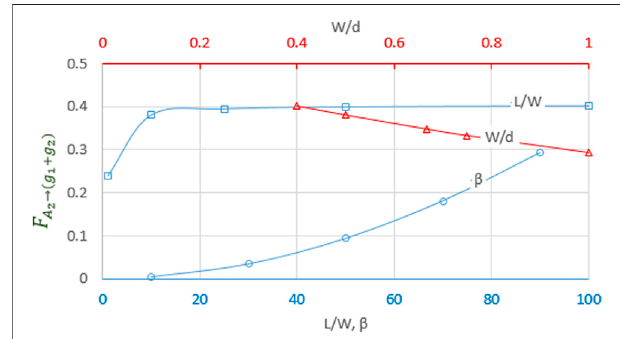
FIGURE 7 | In fl uence of solar fi eld design parameters on F A